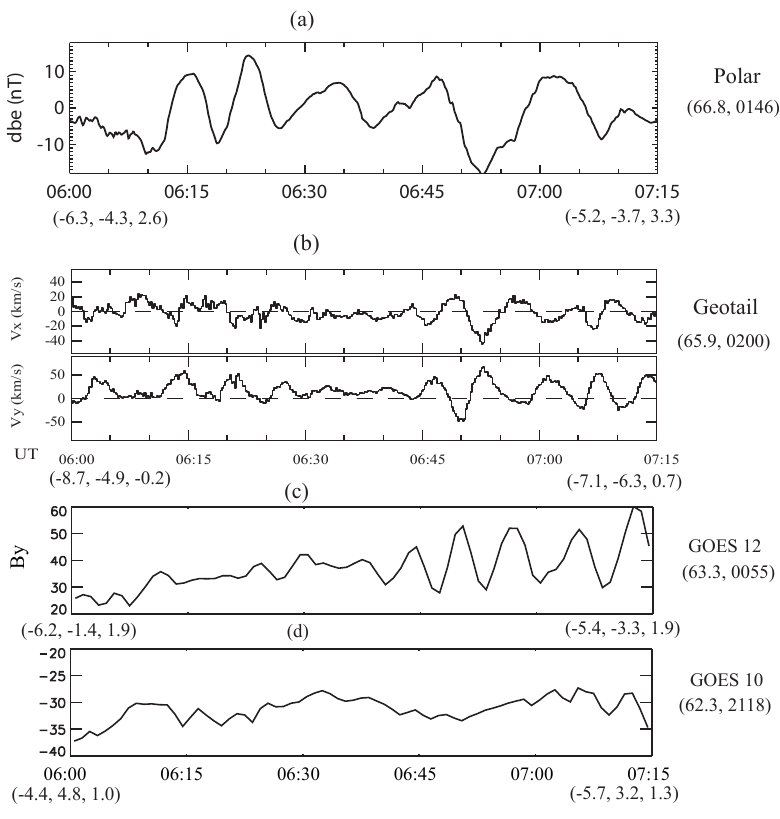
Figure 15 Fig. 15. Oscillations at different frequencies observed by Polar in (a) , Geotail in (b) , GOES 12 in (c) , and GOES 10 in (d) .